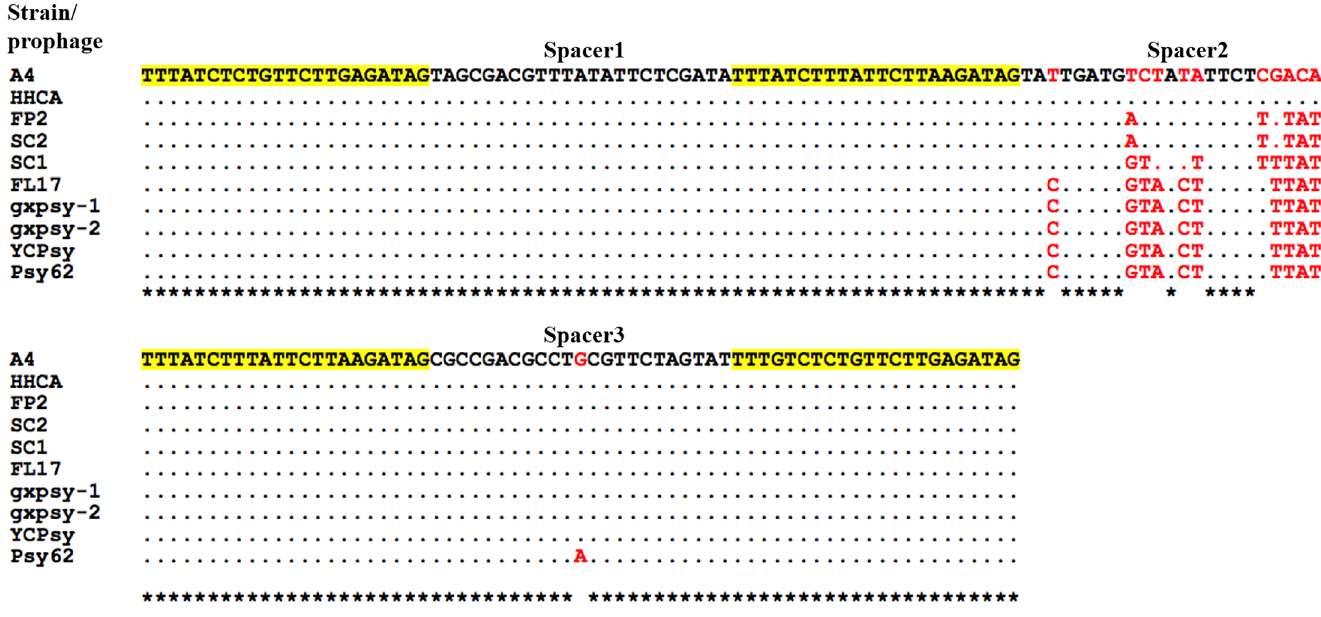
Fig 4. Sequence alignment of a CRISPR (clustered regularly interspaced short palindromic repeats) arrays among ten strains/prophages of “ Candidatus Liberibacter asiaticus ” . Strain A4 was used as a reference. CRISPR repeats are highlighted in yellow. Dots represent nucleotide identity to those of Strain A4. A * at the bottom of alignment indicates identical nucleotides. Nucleotide variations are in red.